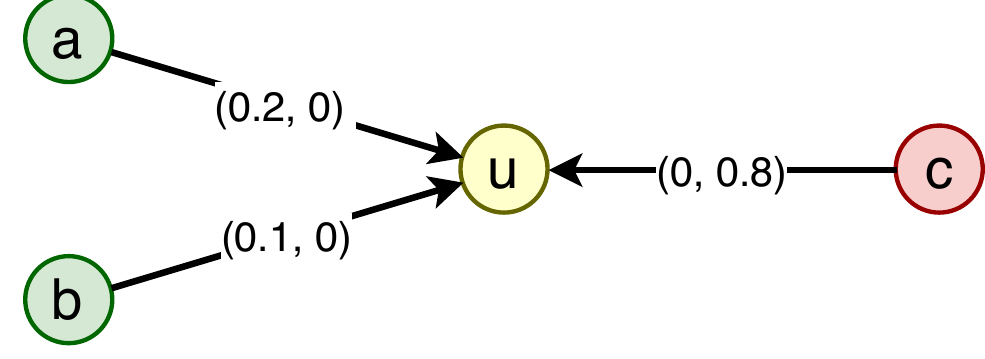
Figure 1. Illustrating for TB-WPP and TB-PP